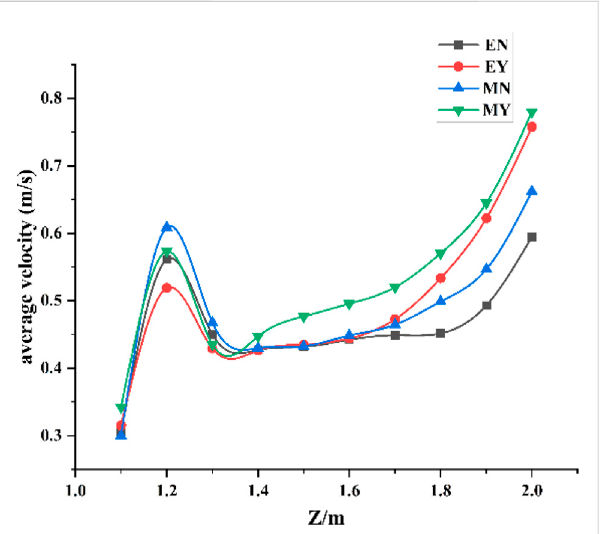
FIGURE 10 Variation curve of average phase velocity along the direction of furnace height at 3 s in four cases.